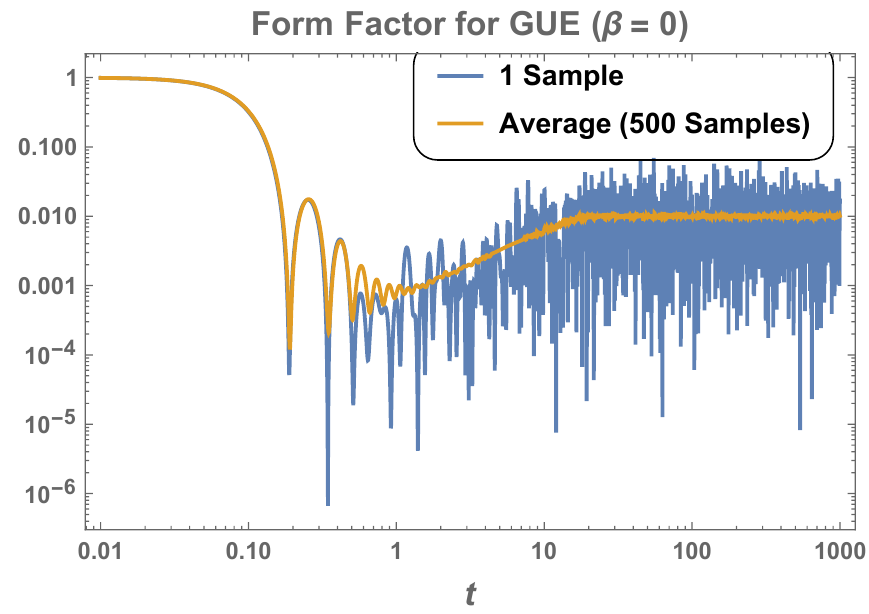
Figure 1 . We plot the infinite temperature form factor for a spectrum generated by 100 × 100 matrices pulled from the Gaussian unitary ensemble (GUE). The blue line is the form factor for a single sample matrix from the GUE and the yellow line is the 500 sample average. One can see that at late times, the averaged form factor exhibits a linear ramp followed by a